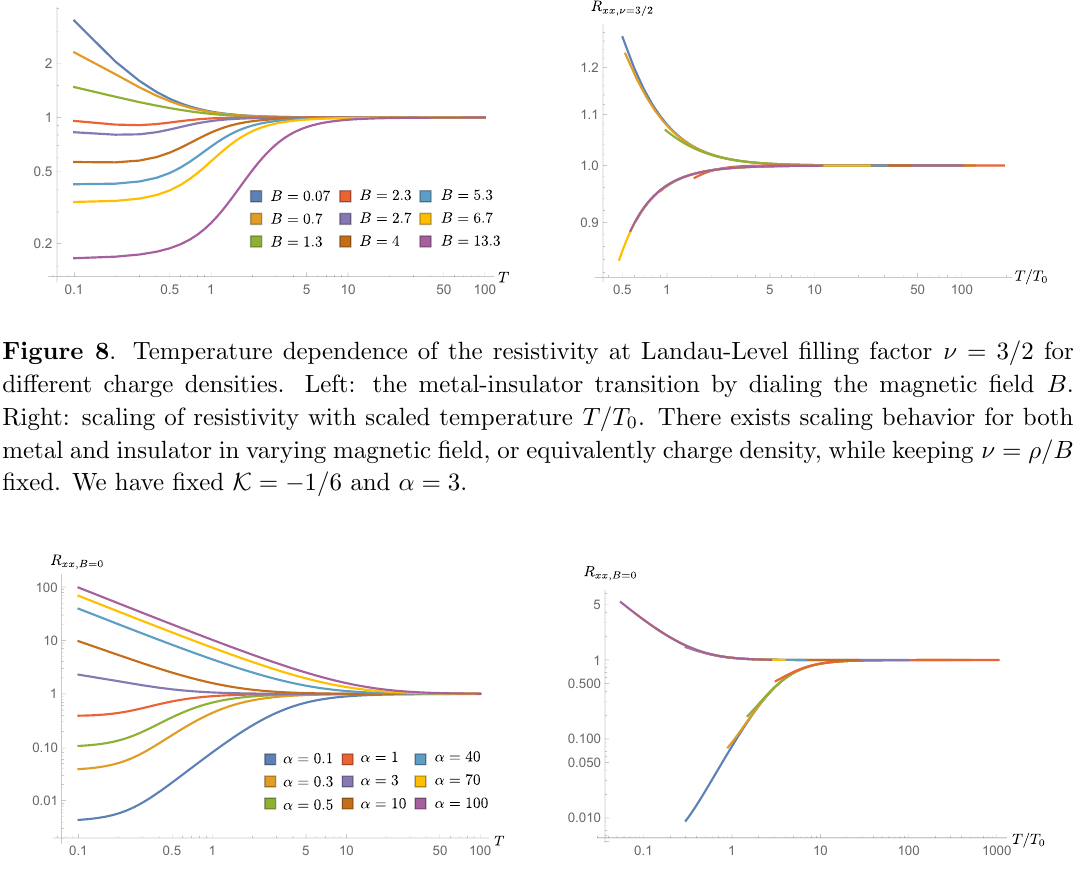
might be controlled by the same underline physics when viewed in terms of